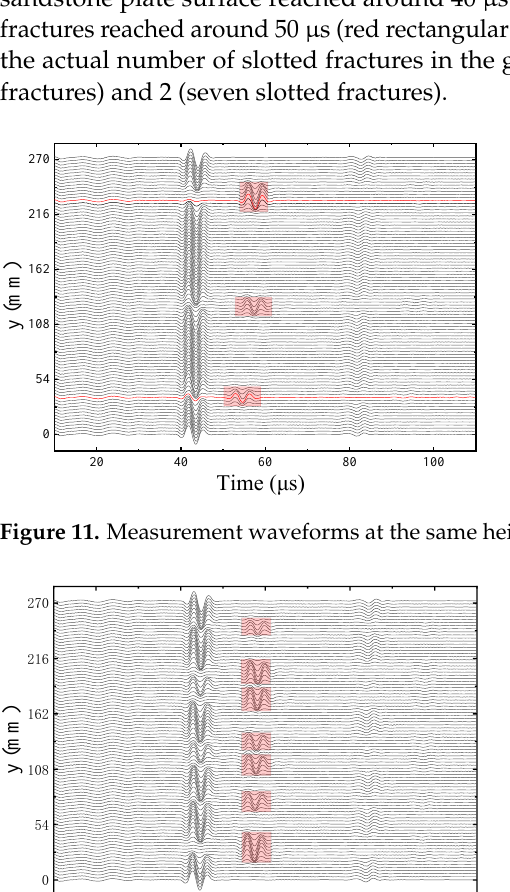
Figure 10. Schematic of the measurement method of the simulated borehole. ( a ) Schematic of the position of the transducer in the experimental measurement and ( b ) Schematic of the moving track of the ultrasonic transducer, unfolded drawing along the inner wall of the borehole.